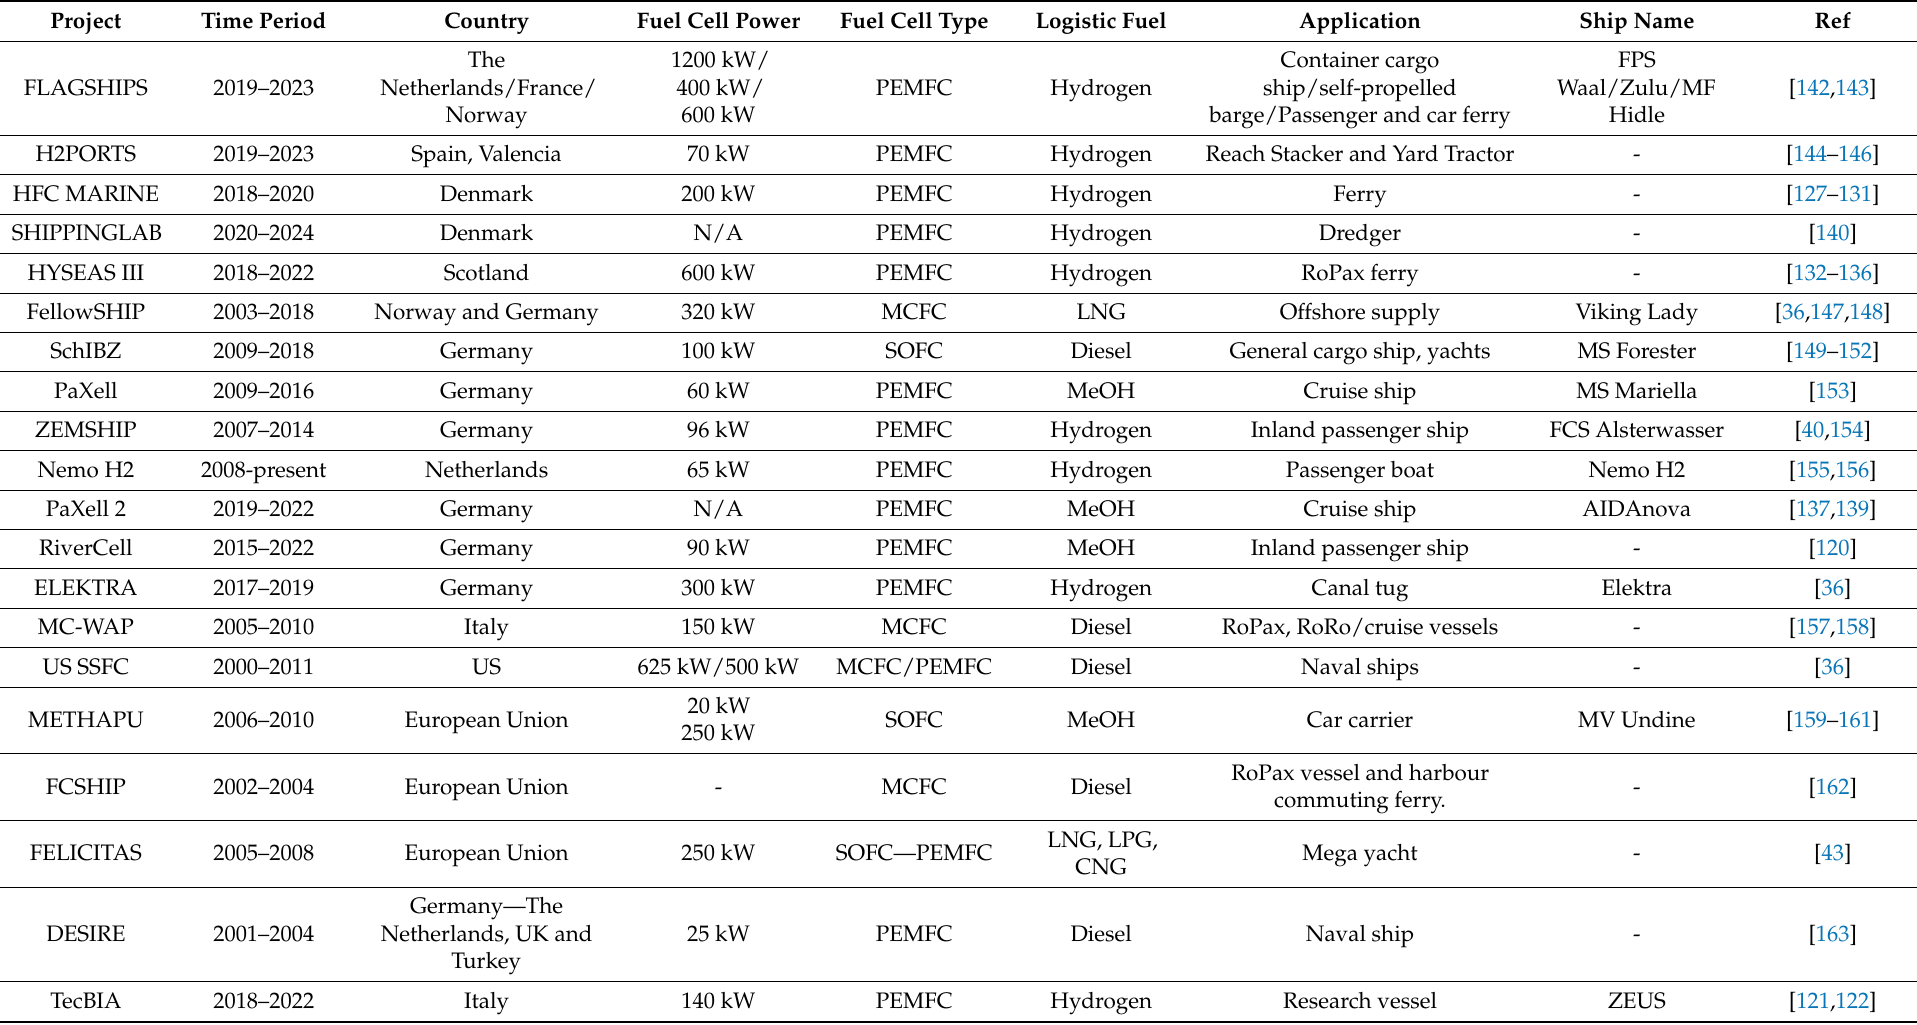
Table 5. Overview of international research projects for fuel cell systems in maritime